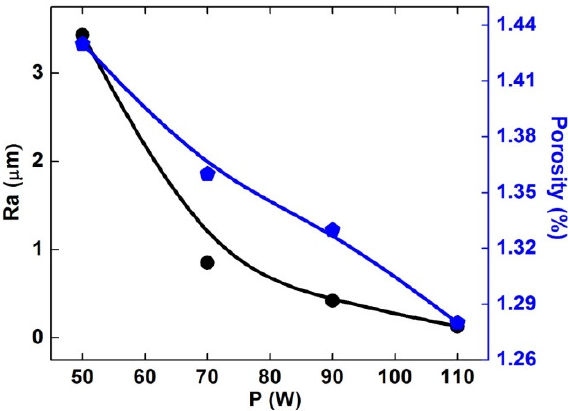
Figure 10. Variation of the surface roughness and porosity as a function of laser power.